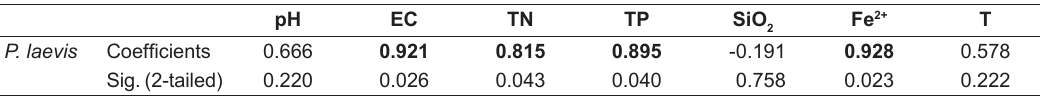
Figure 4. Hierarchical clustering (Euclidean distance; Ward algorithm) of the substrate types (a) and sampling stations (b) based on relative abundance of P. laevis Table 3. Pearson correlation coefficients between P. laevis relative abundance and all measured physicochemical parameters.